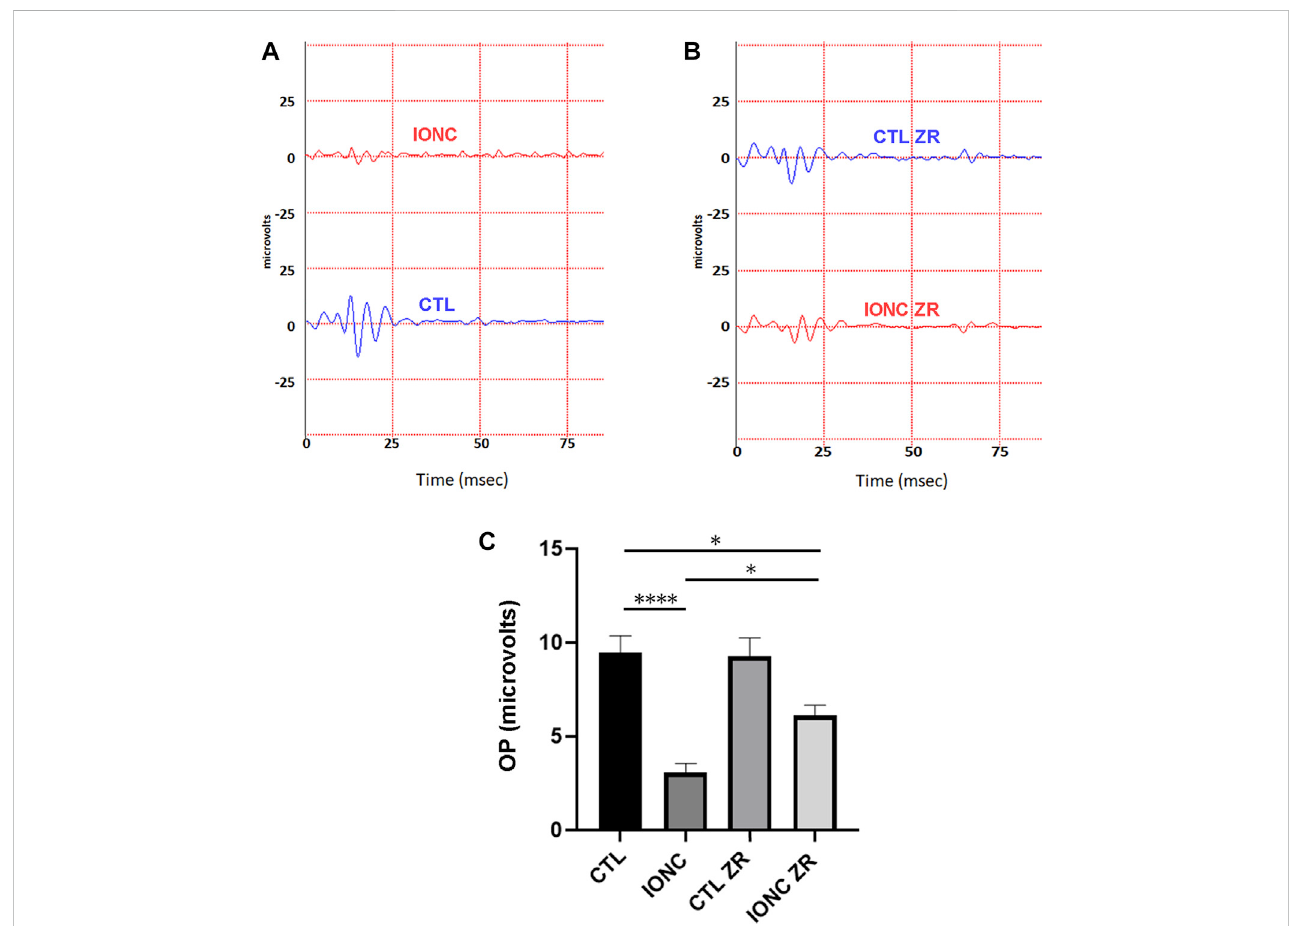
FIGURE 3 Electroretinograms and quanti fi cation of oscillatory potentials on the four experimental groups. Representative electroretinograms of vehicle- (A) and zr17-2-treated (B) animals subjected to IONC (red lines) or sham-operated (blue lines). Oscillatory potentials of the four groups were quanti fi ed (C) . Bars represent the mean ± SD of all animals ( n = 9 per experimental group). Asterisks represent statistically signi fi cant differences (ANOVA). *: p < 0.05; ****: p <